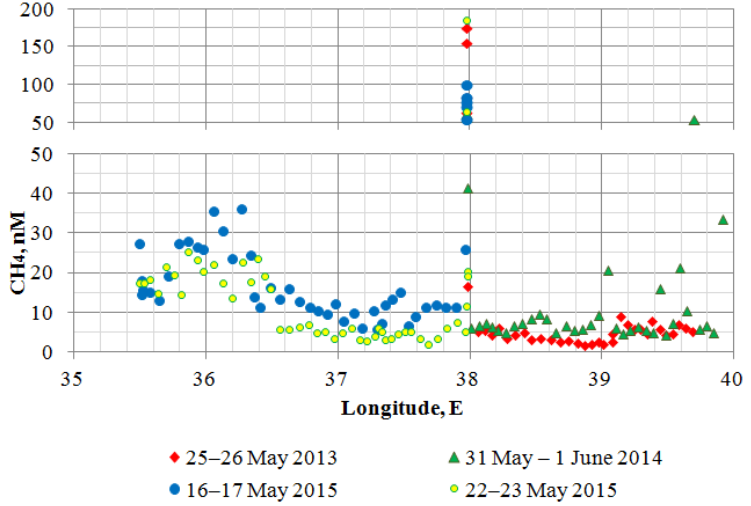
Figure 7. Dissolved methane content in the surface waters on sections in the northeastern Black Sea (2013–2015).